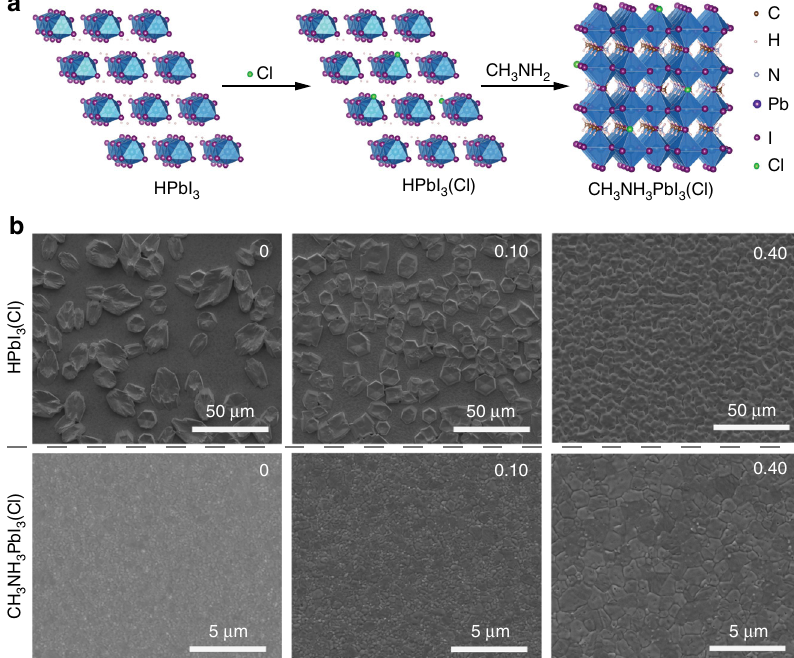
Fig. 1 Perovskite fi lm formation. a Schematic drawing showing the reaction process of partial substitution of iodine ions by chorine ions to form chlorine- incorporated perovskite MAPbI 3 (Cl) fi lms: First, iodine ions in HPbI 3 are partially substituted by chorine ions to form HPbI 3 (Cl). Then HPbI 3 (Cl) reacts with CH 3 NH 2 gas to form MAPbI 3 (Cl) via the ultra-fast acid-base reaction. b Top-view SEM images of HPbI 3 (Cl) (top set, scale bar: 50 μ m) and MAPbI 3 (Cl) (bottom set, scale bars: 5 μ m) fi lms prepared using different molar ratios of MACl versus HPbI 3 in the HPbI 3 /MACl precursor